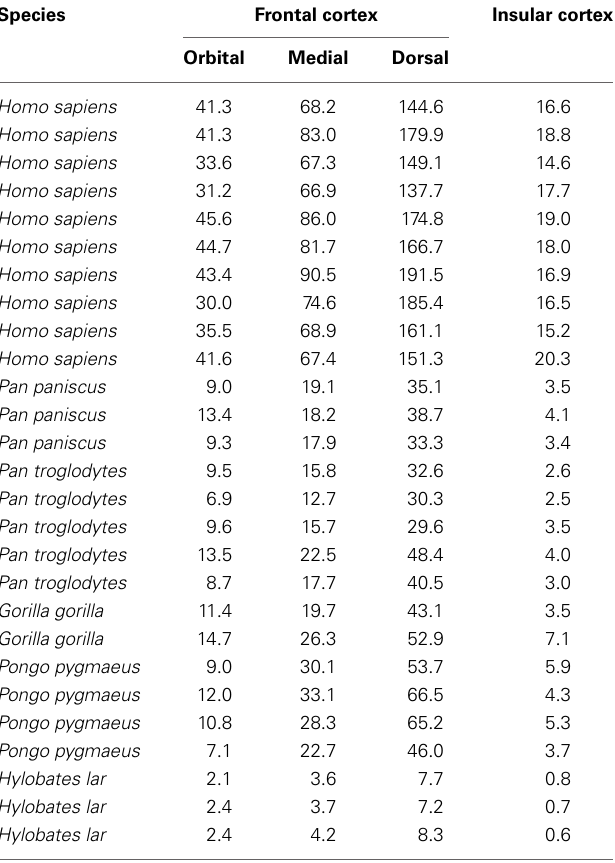
Table 2 | Volumes of sectors of the frontal cortex (Schenker et al., 2005) and of the insular cortex (Semendeferi and Damasio, 2000) in both hemispheres of individual hominoid specimens measured in cubic centimeters